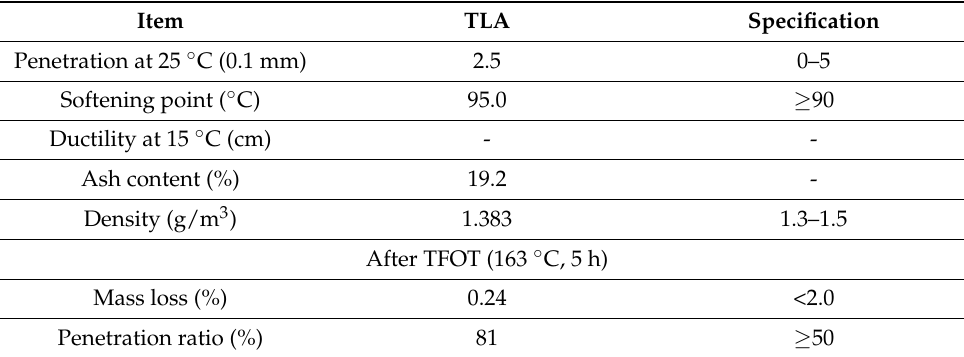
Table 2. Typical characteristics of Trinidad lake asphalt (TLA).